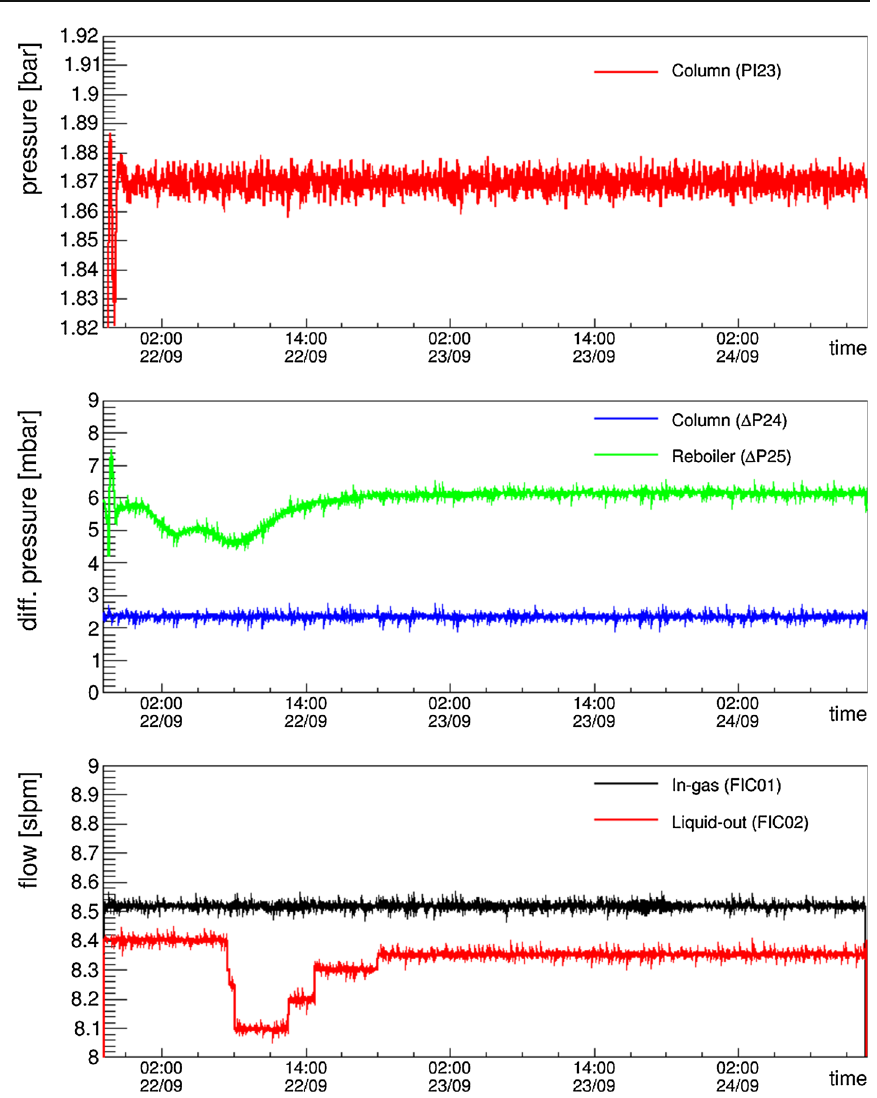
Fig. 7 Thermodynamic stability of the final XENON1T distillation setup. The plots show the key parameters for a distillation test at LNGS over several days. The width and small spikes of the measurements are created by sensor inaccuracy and do not reflect the actual performance. Top Pressure PI23 inside the package material. Middle Pressure drop along the package tube ( (cid:5) P24) and hydrostatic pressure of the liquid xenon reservoir in the reboiler ( (cid:5) P25). Bottom Flow rates in the in-gas line (FIC01) and in the liquid-out line (FIC02). Thermodynamic stability is reached after about